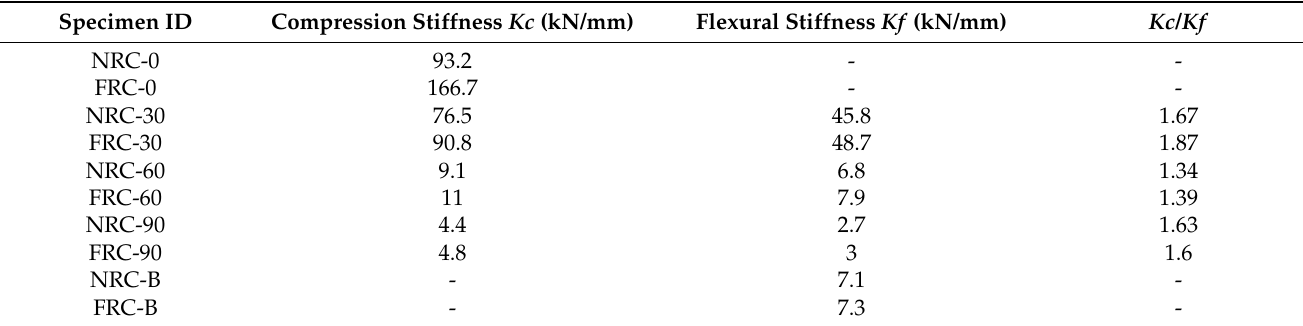
Table 8. Compressive stiffness and flexural stiffness of specimens.